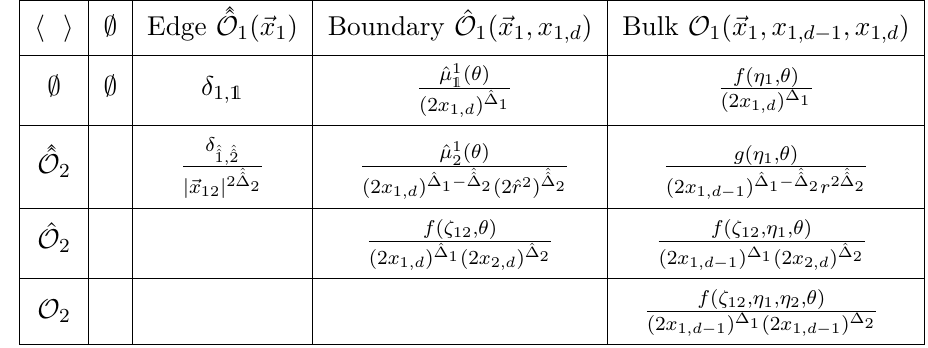
Table 1 . Possible one- and two-point functions in the wedge configuration. We emphasize their position and cross ratio dependence as well as the CFT data